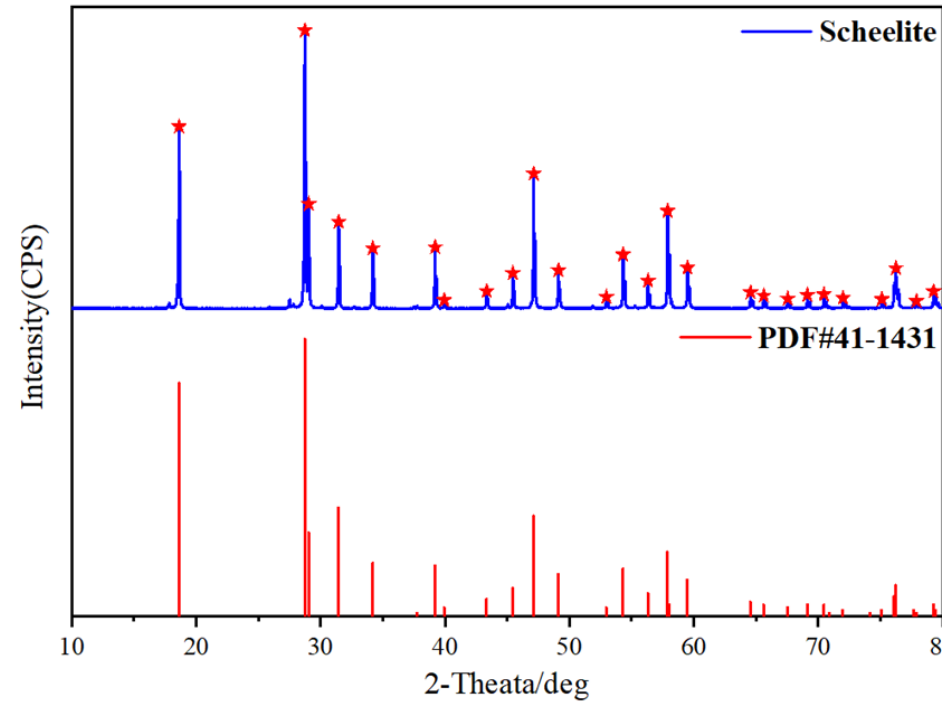
Figure 1. X-ray diffraction pattern of pure scheelite.